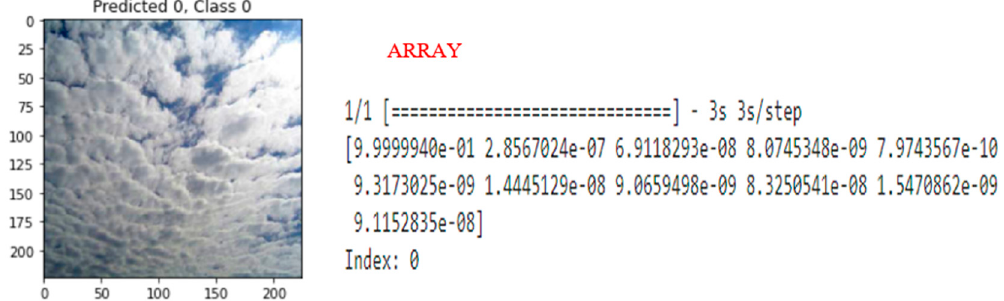
Figure 7. Sample predicted cloud, class, and array.